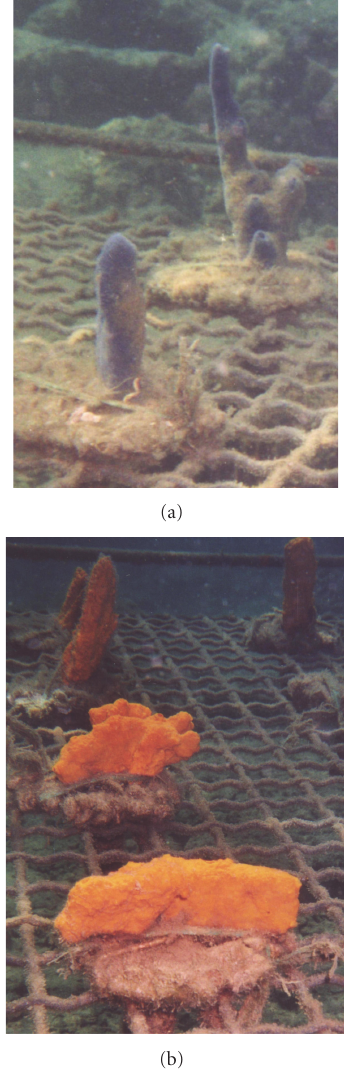
Figure 1: Neopetrosia sp. (a) and Stylissa massa (b) fragments attached to the artificial substrate and placed on a metal grid at Teluk